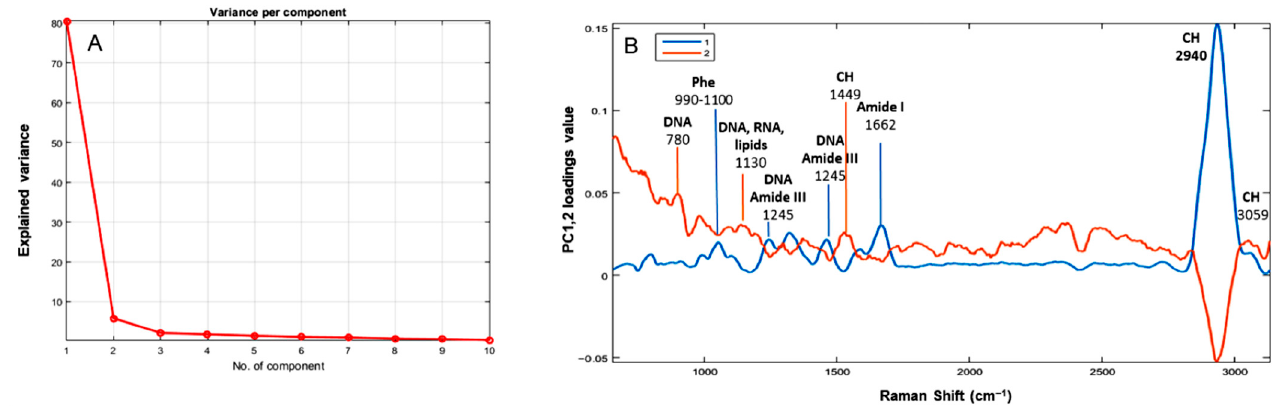
Figure 4. ( A ) Explained variance by the first 10 PCs. ( B ) Loadings profile of PC1 ( blue ) and PC2 ( orange ) in the range between 666 and 3120 cm − 1 with corresponding chemical band assignment.